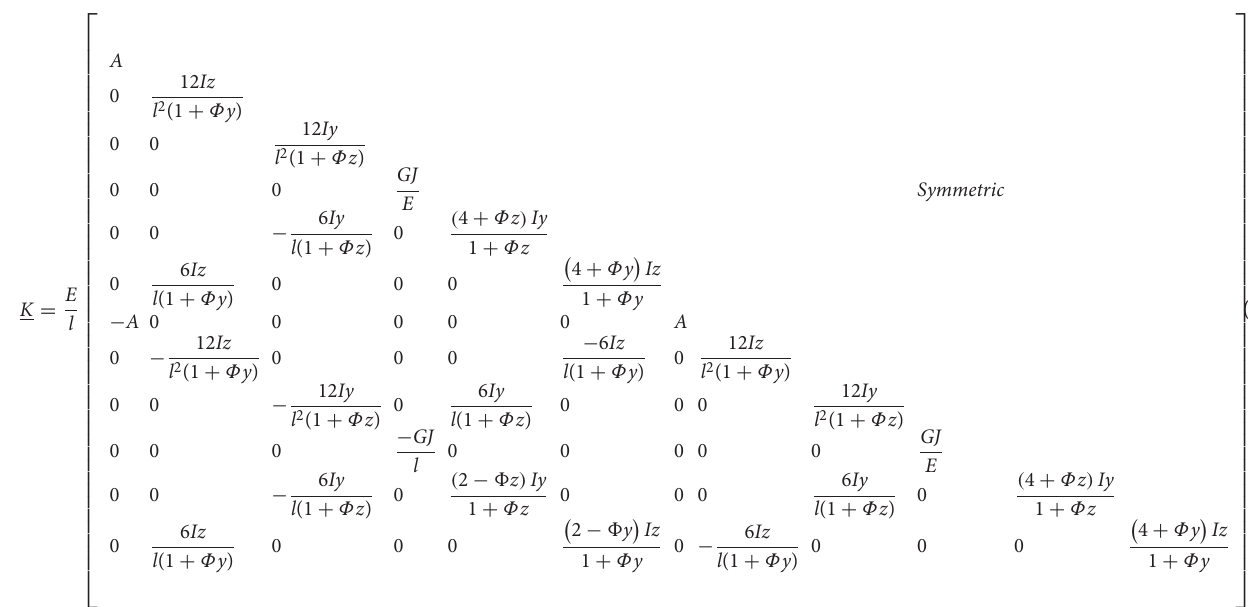
FIGURE 2 | Schematic representation of the corotational approach (A) ; application in the method, in step 1 of stage 1 modeling of the stent-graft centerline (on the left), in step 2 of stage 2 modeling of the stent struts (on the right) (B) . The arrows show corotational beam elements between connecting